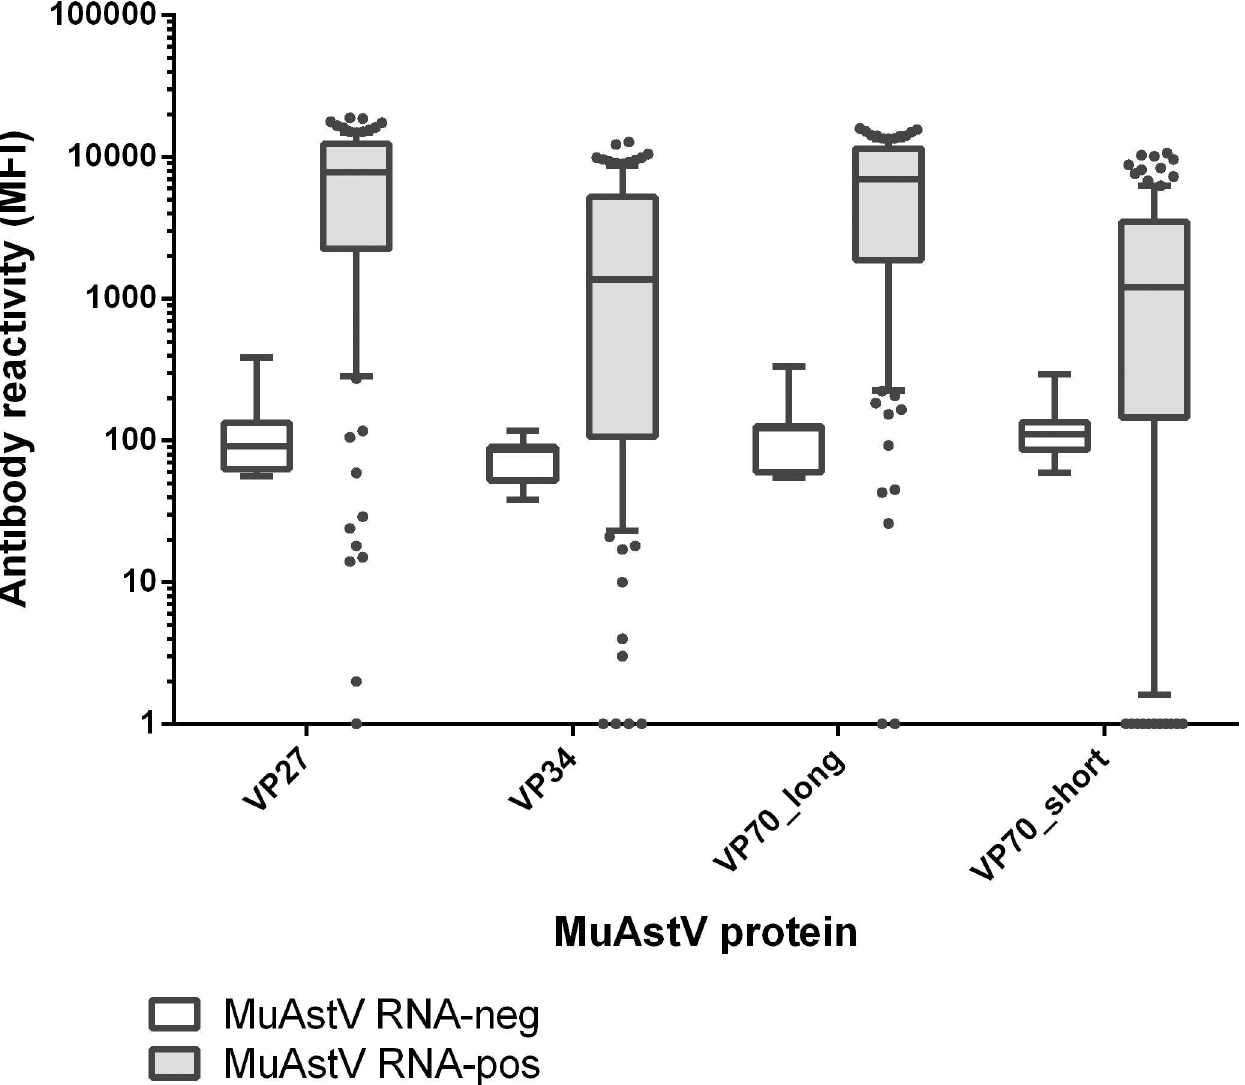
Fig 2. Comparison of antibody reactivities of four MuAstV recombinant proteins in multiplex serology. Box plot of net MFI values (S1 Dataset) are shown. Boxes are delimitedby the first and third quartile(IQR, Q1-Q3) and represent 50% of data. Whiskers show the 10 th and 90 th percentiles,respectively.The dots represent data points beyondthe upper and lower 10 th percentile.The line insidethe boxes representsthe median. The distributionof MFI values of the negativesera (n = 7) are shown in white boxes, those of the positive sera (n = 112) in grey boxes. All four antigens show significantdifferences betweenpositive and negativeserum samples (VP27 and VP70 long P < 0.001, VP34 P = 0.008, VP70 short P = 0.015, Mann-Whitney Rank Sum test).